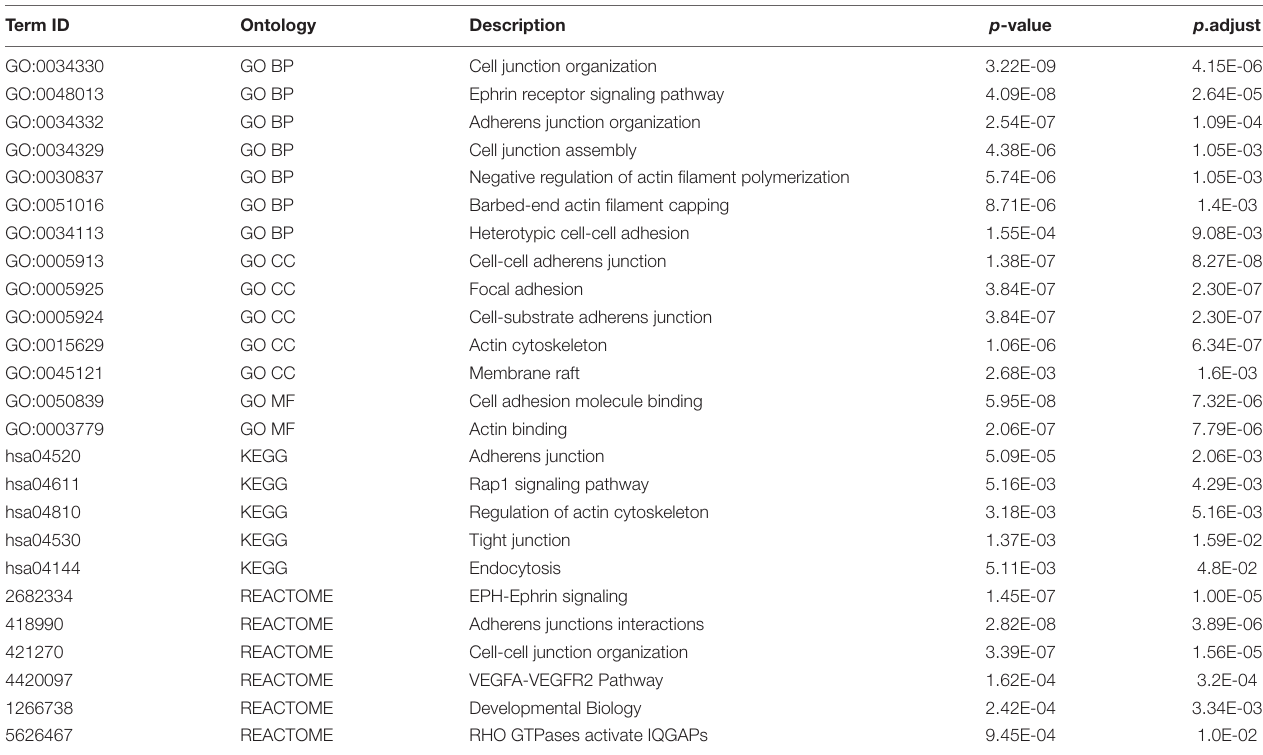
TABLE 4 | Functional enrichment for 39 shared proteins. Term ID Ontology